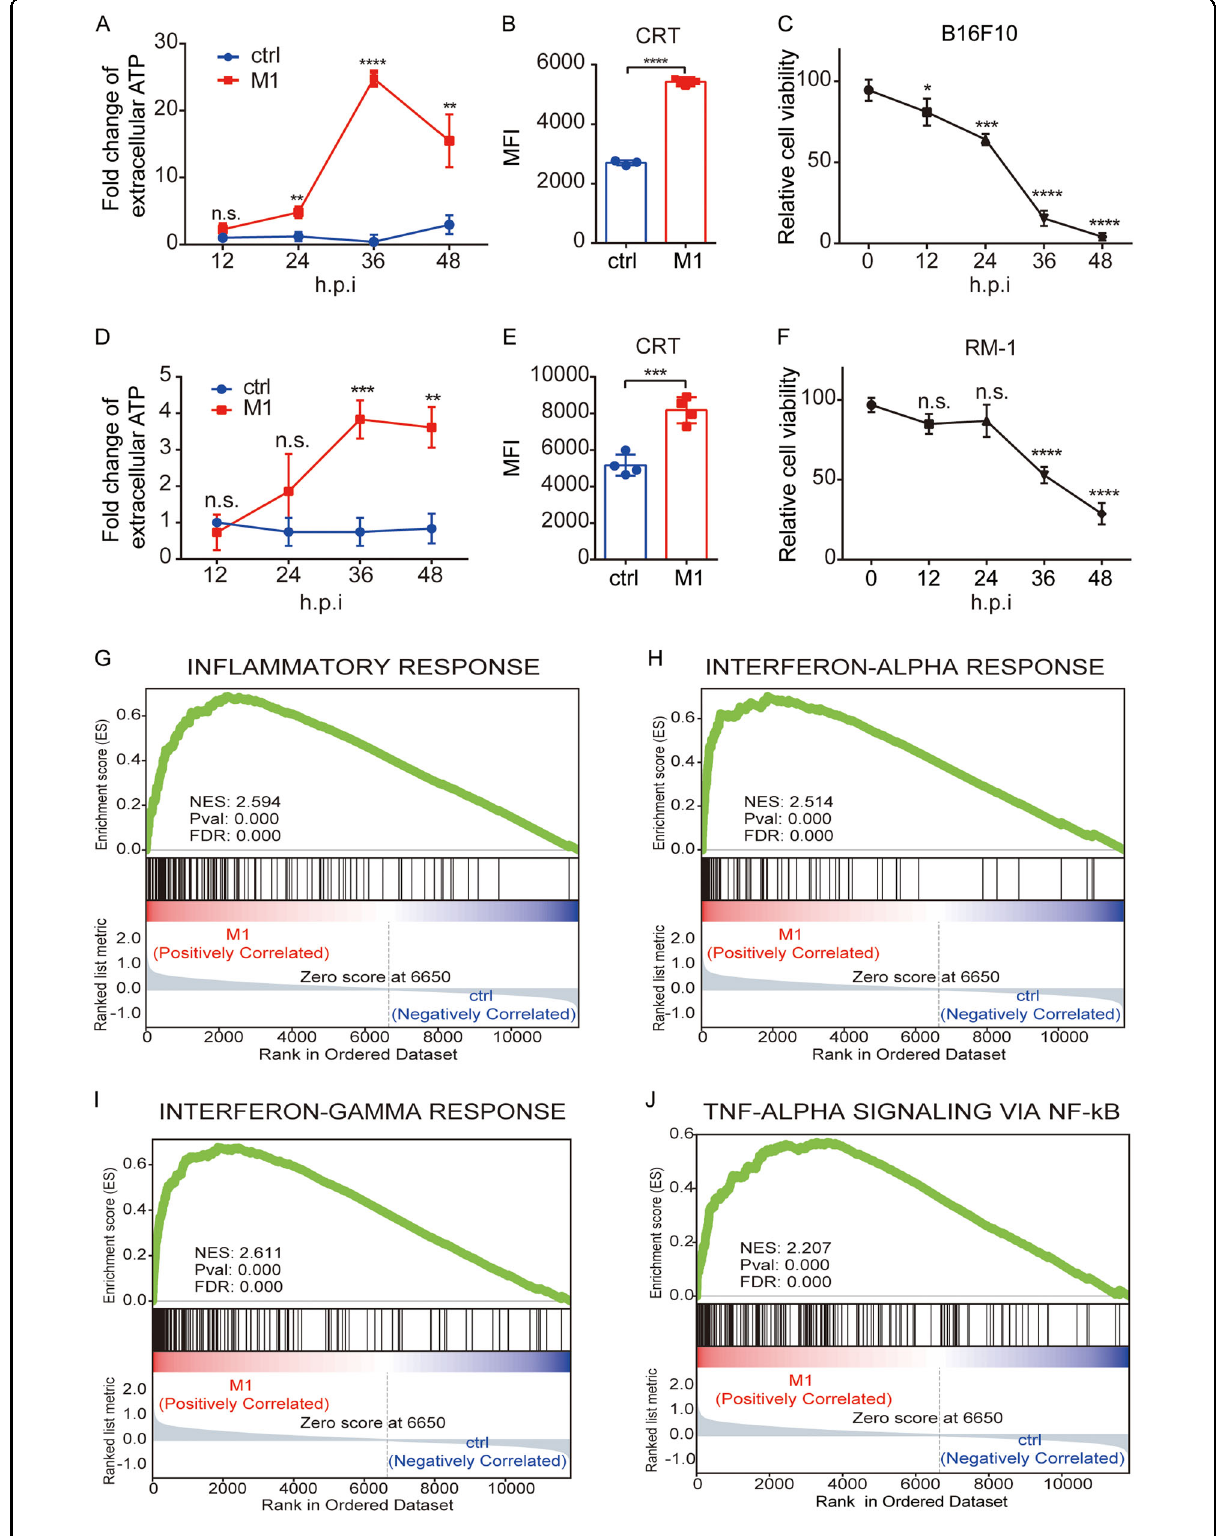
Fig. 2 (See legend on next